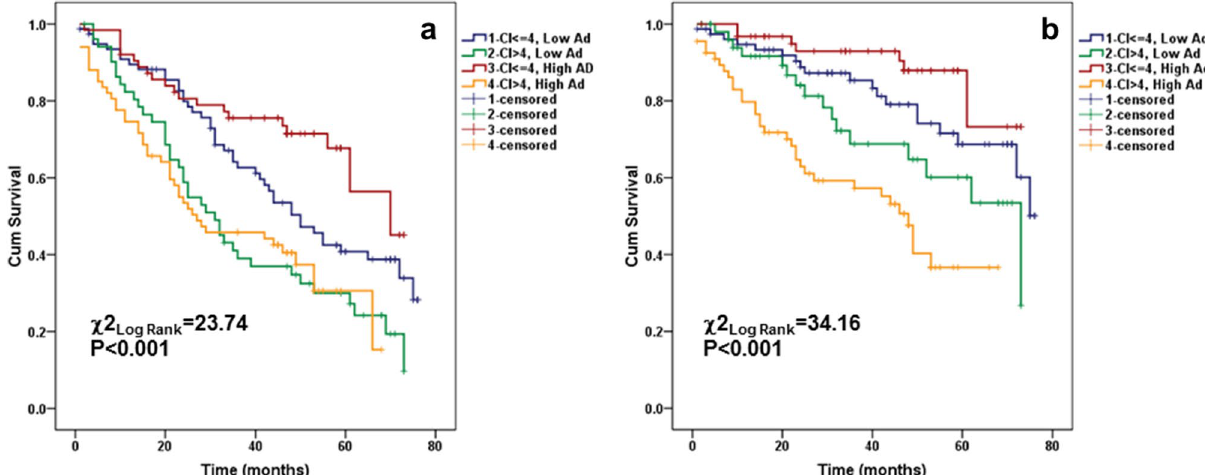
Figure 3. Kaplan–Meier survival curves of surviving patients comparing subgroups with the baseline serum comorbidity index and adiponectin categories (comorbidity index below and above median (4.0) and adiponectin below and above median (8.28 mcg/ml) values) cross-classified in 261 MHD patients followed for up to 6 years: ( a ) all-cause mortality, and ( b ) cardiovascular